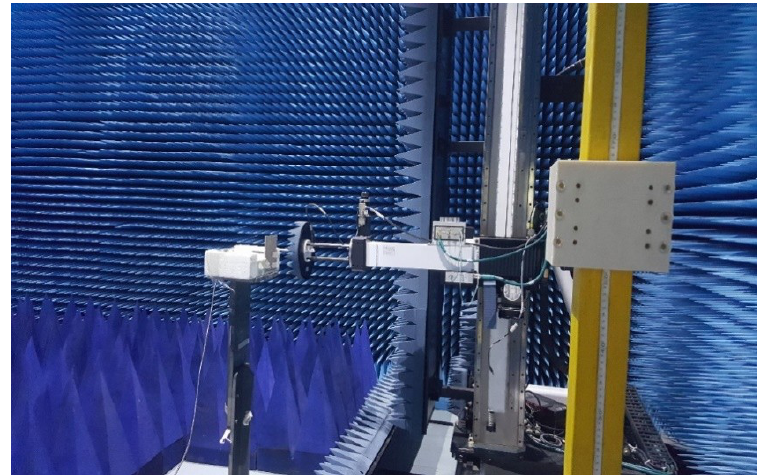
Figure 18. Measurement set-up of AUT for diagnostic purpose.